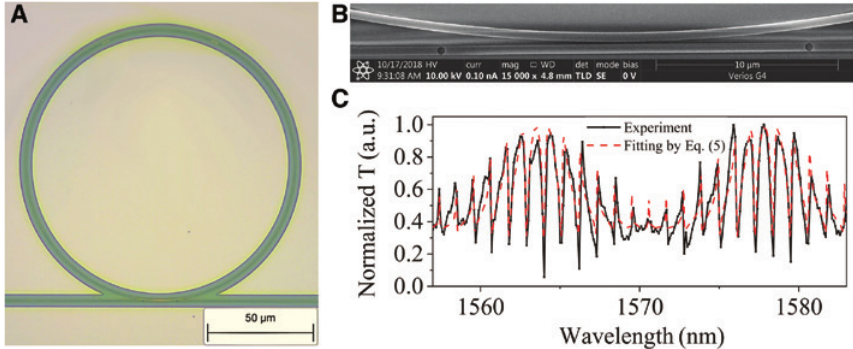
Figure 3: Fabricated FP-MRR device and its transmission spectrum. (A) Optical microscope image of one of the fabricated device; (B) scanning electron microscope image of the WG-MRR coupling region with two air-holes inserted in the bus-WG; (C) measured transmission spectrum of the fabricated device (black line) and fitting result by Eq. (5) (red dashed line), showing Lorentzian, Fano, and electromagnetically induced transparency resonance lineshapes over the FP